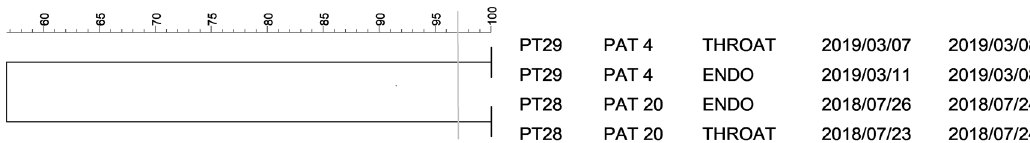
Figure 4. Dendrogram for restriction patterns of E. coli isolates. Legend: horizontal axis—similarity of isolates (%); vertical axis—pulsotype, patient code, type of sample, date of sample collection, date of VAP diagnosis; PT pulsotype, PAT patient, ENDO endotracheal aspirate sample, THROAT throat swab. The vertical line indicates the similarity threshold set at 97%.